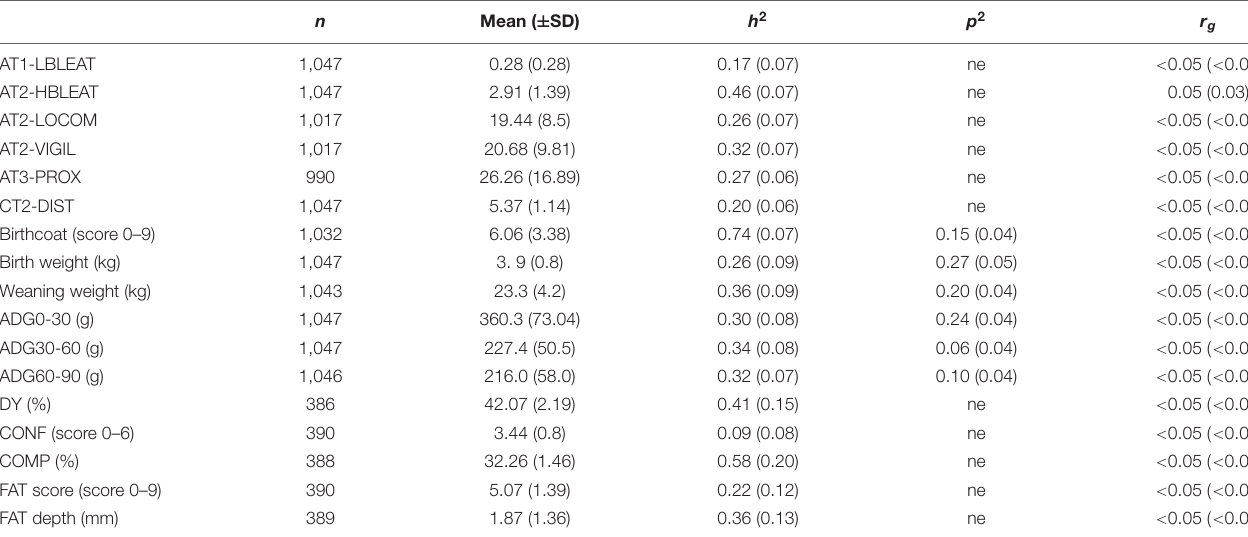
TABLE 3 | Number of records, mean ( ± SD), estimates of heritability, and permanent environmental effects for behavioral, zootechnical and carcass traits, and genetic correlations between these traits and the global DNA methylation rate.